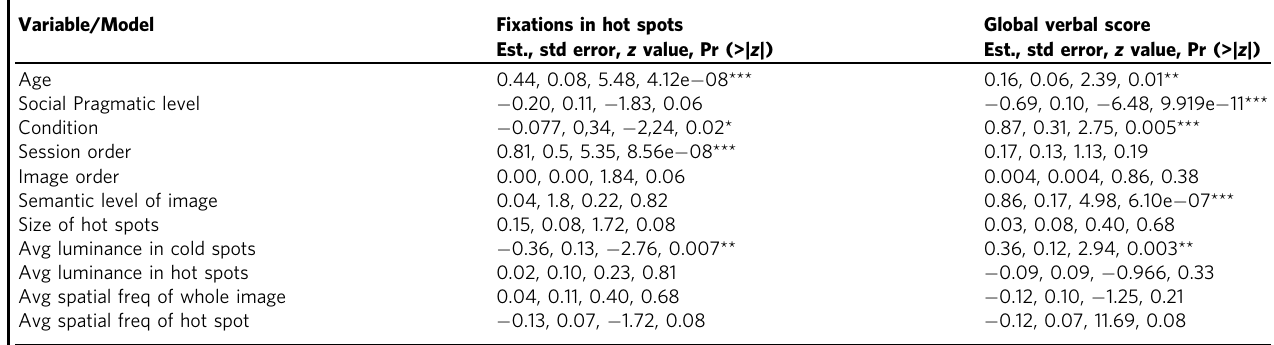
Table 2 Results of the General Linear Regression models.